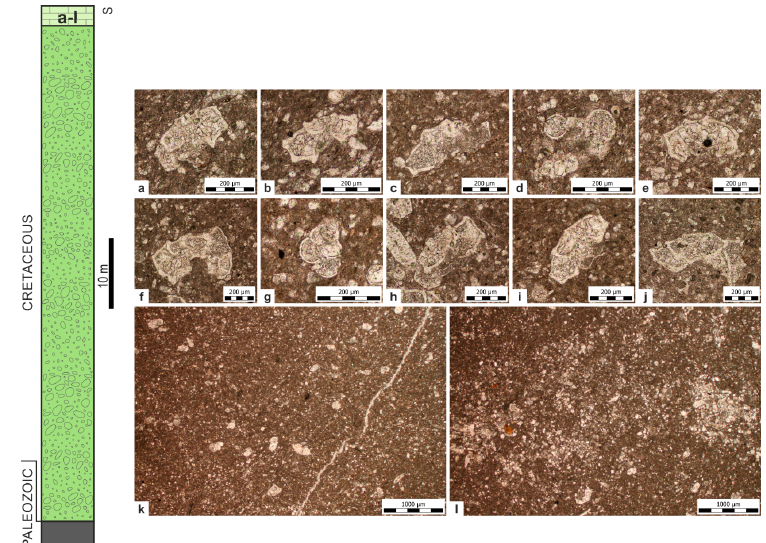
Figure 10. Photomicrographs in transmitted light of planktic foraminifera and pelagic facies from the Scaglia Limestones at the top of the studied section. ( a , i ) Globotruncana linneana (d’Orbigny): ( b ) Globotruncana bulloides Vogler: ( c ) Marginotruncana pseudolinneana Pessagno; ( d ) Globigerinoides cf. bolli Pessagno; ( e , f ) Globotruncana cf. ventricosa White; ( g ) Heterohelix punctulata (Cushman); ( h ) Globotruncana cf. linneana (d’Orbigny); ( j ) Globotruncana orientalis El Naggar. Panoramic view of two types of pelagic deposits: nonlaminated ( k ) and slightly laminated ( l ). Position of Sampling Stop 7 marked on the schematic column.